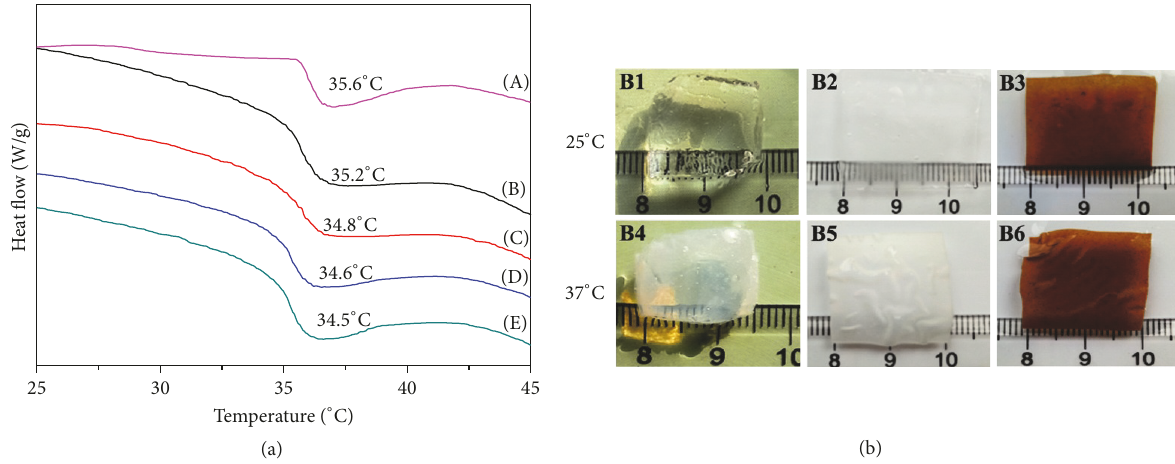
Figure 5: (a) DSC thermograms of PNIPAM (A), PNIPAM/KGM (B), PNIPAM/KGM/GO1 (C), PNIPAM/KGM/GO2 (D), and PNIPAM/ KGM/GO3 (E) composite membranes. (b) PNIPAM (B1 and B4), PNIPAM/KGM (B2 and B5), and PNIPAM/KGM/GO3 (B3 and B6) composite membranes with the volume conversion at 25 ∘ C and 37 ∘ C, respectively.